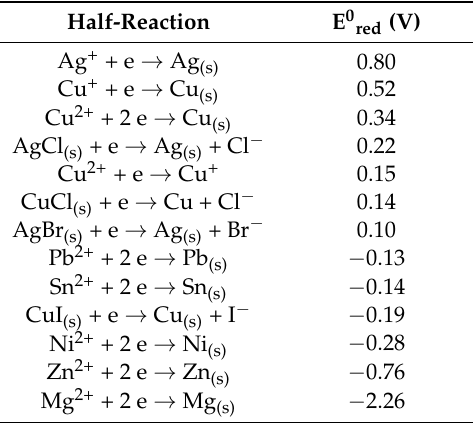
Table 3. Standard reduction potentials of some half-reactions